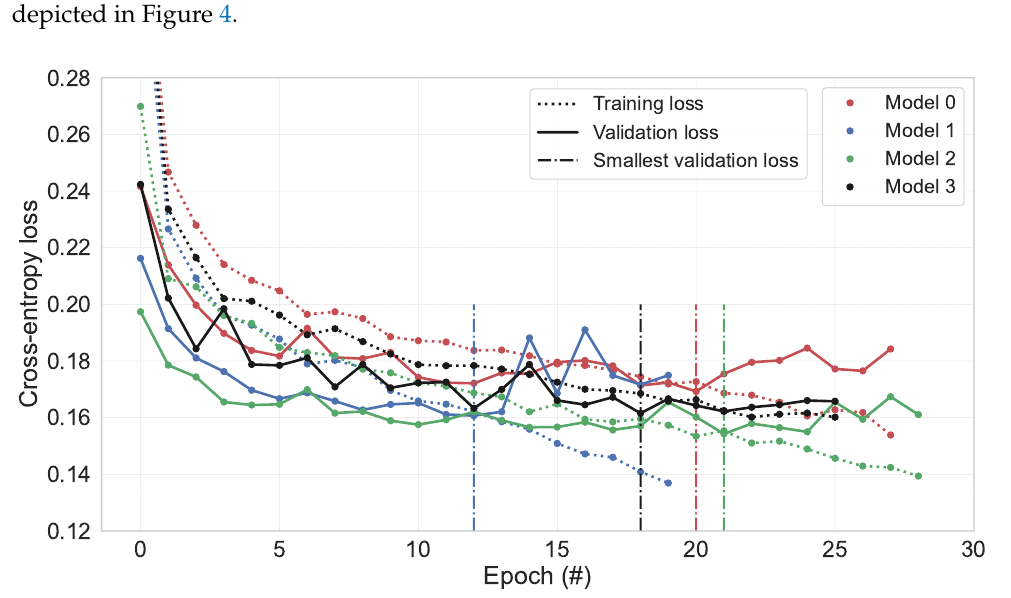
Figure 4. History of training and validation cross-entropy losses. Early-stopping was implemented with a patience equal to κ =